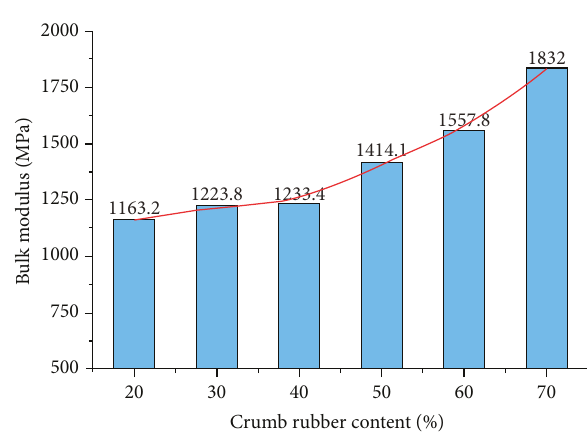
Figure 6: Bulk modulus of six CRMA